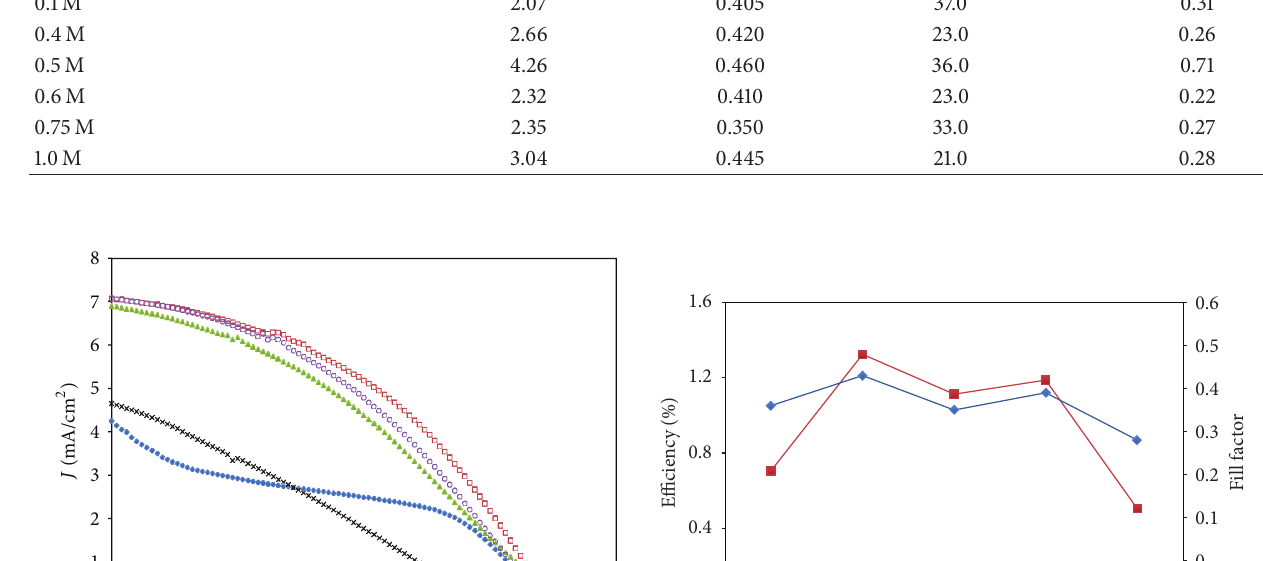
S in ethanol/water (8:2 by volume) 2